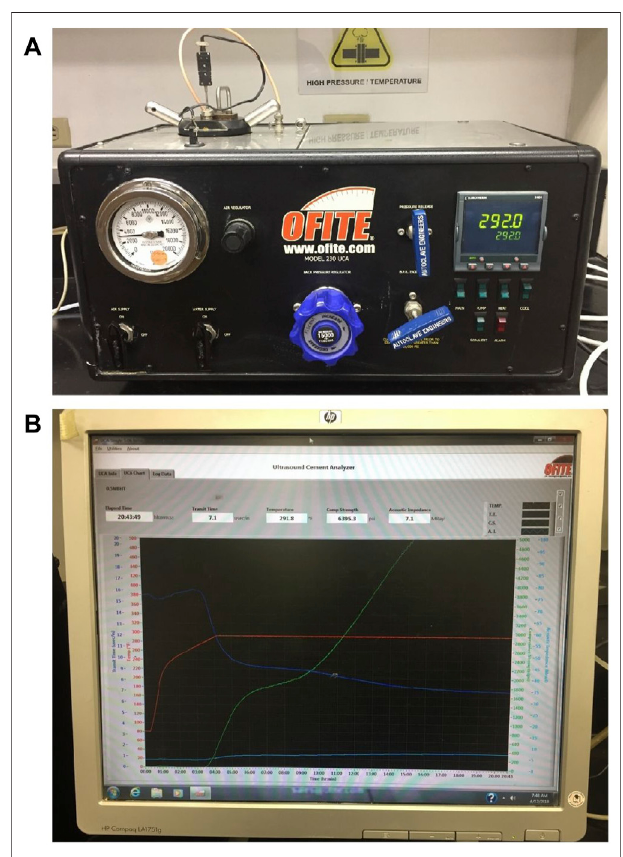
FIGURE 4 | UCA Device and Monitoring Curve Sample. (A) is a UCA device. (B) is one UCA monitoring curve sample).